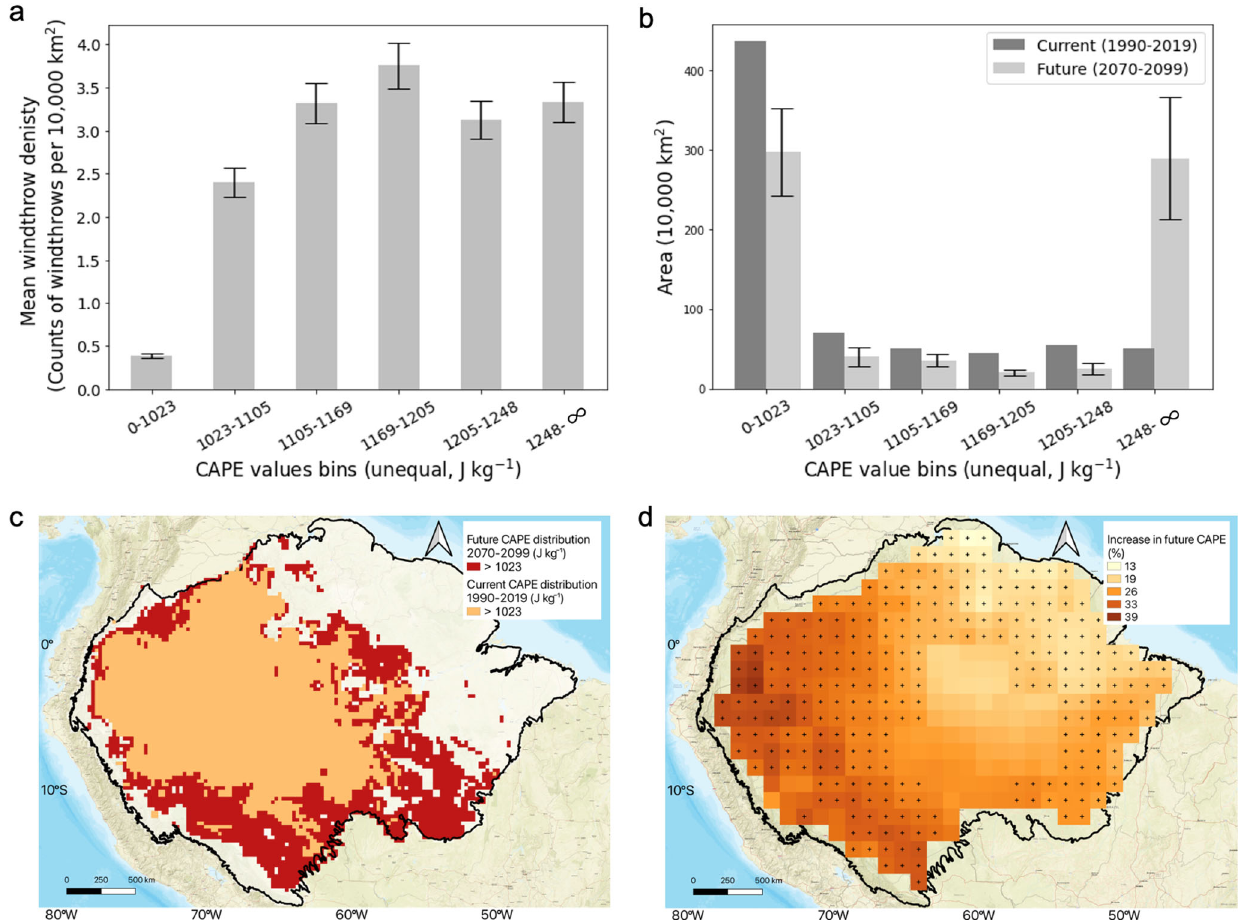
Fig. 2 | The relationship maps convective available potential energy (CAPE) to windthrow density and future increase in CAPE simulated by Earth system models under the high-emission scenario. a Mean windthrow density as a function of CAPE values, calculated using the data shown in Figs. 1a, c. The boundaries of the CAPE bins were selected to have the same number of observed windthrows in each bin to avoid noise at the tails. The error bars (SD) of the windthrowdensityweregeneratedusing10,000bootstrappedsamplesofthe1012 windthrow points. The lower and upper CAPE bin boundaries were expanded to a minimum of 0 and a maximum of in fi nity with an assumption that the windthrow densityissimilarfortheneighboringCAPEvalues. b TheareaoftheAmazonregion in each CAPE binforthe past 30 yearsand for the last 30yearsof the century. The